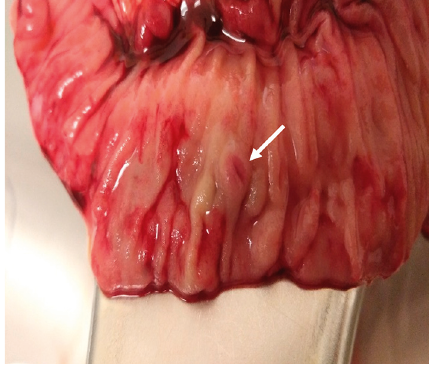
Figure 5: The resected part of the ileum.